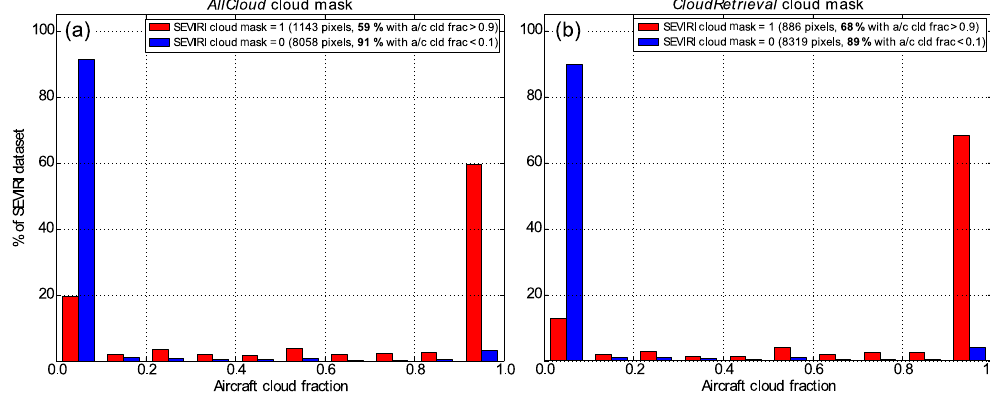
Figure 6. Histogram containing the full Fennec dataset to show the statistical agreement between the SEVIRI and aircraft cloud masks for (a) AllCloud and (b) CloudRetrieval. Histograms are as described in Fig. 5.